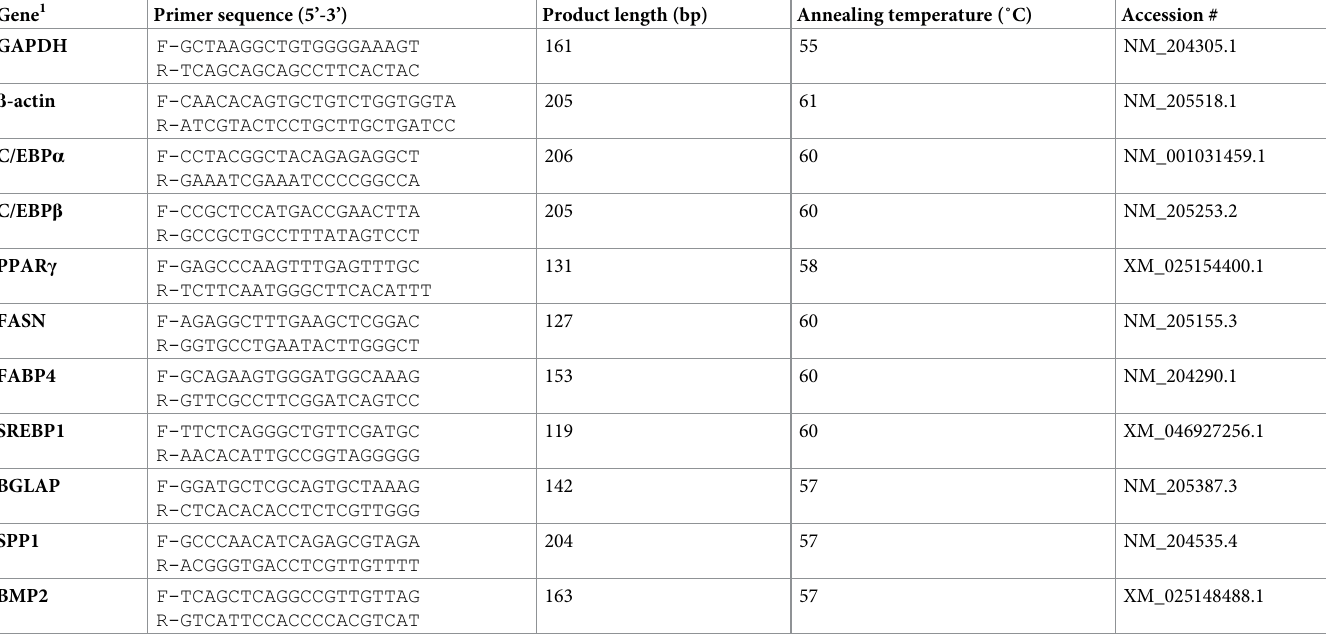
Table 2. Nucleotide sequences of the primers used for quantitative real-time RT-PCR. Gene 1 Primer sequence